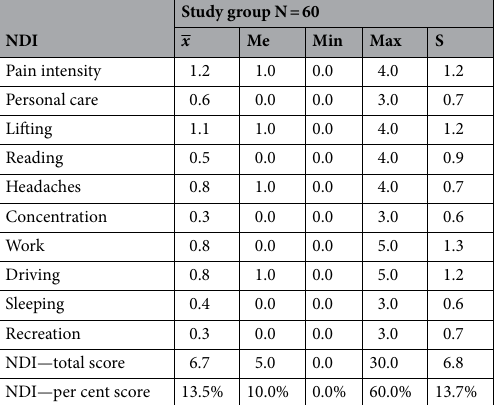
Table 3. Mean scores in the sections of NDI questionnaire. x mean, Me median, S standard deviation, Min minimum value, Max maximum value.